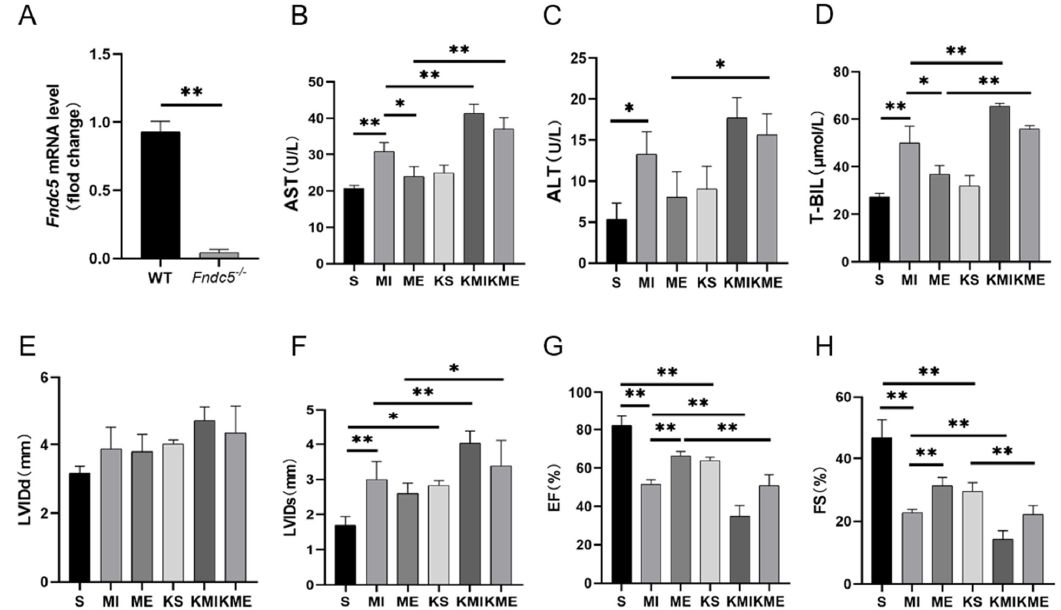
Figure 3. Effect of Fndc5 knockout on the MI-induced liver injury and the benefits of AE. ( A ), RT- qPCR results of Fndc5 in the WT and Fndc5 -/- mice; ( B – D ), serum levels of AST, ALT, and T-BIL; ( E – H ), hemodynamic results. Data are expressed as mean ± SEM, n = 6. * p < 0.05, ** p < 0.01 by two-way ANOVA. S: sham group; MI: myocardial infarction group; ME: MI with AE group; KS,